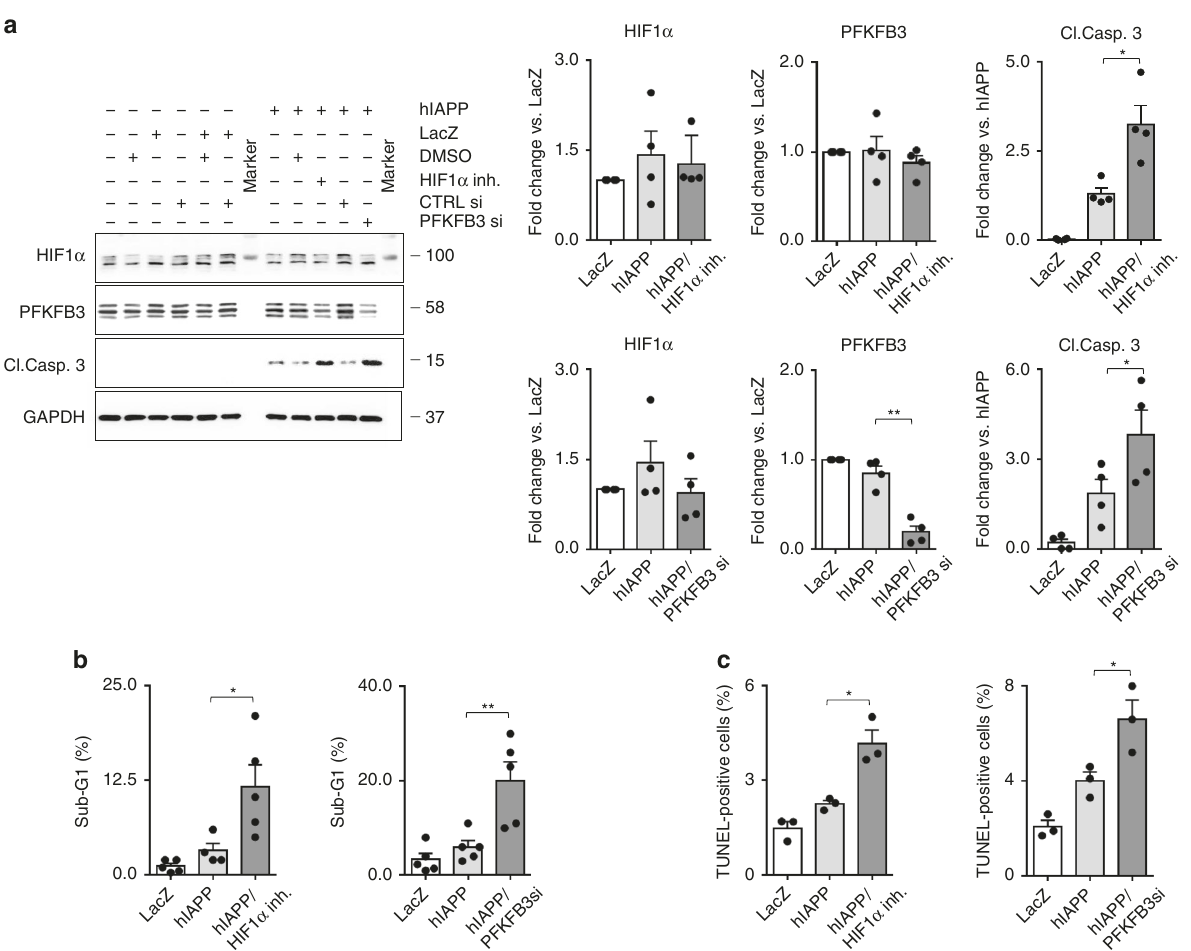
Fig. 9 HIF1 α and PFKFB3 are protective against hIAPP mediated β -cell death. a Representative immunoblotting (left) and quanti fi cation (right) of the whole cell extract (WCE) from asynchronous INS 832/13 cells treated with either HIF1 α inhibitor KC7F2 (10 μ M) or PFKFB3 siRNA (75 nM) for 56 h versus control. Cells were transduced with hIAPP adenovirus (75 MOI) or LacZ adenovirus as control (75 MOI) for last 32 h of culture. DMSO or CTRL siRNA, respectively were added to LacZ or hIAPP to equal DMSO or PFKFB3 siRNA used in experimental groups. GAPDH was used as a loading control. Data are presented as mean ± SEM, n = 4, * p < 0.05, ** p < 0.01. b Quanti fi cation of DNA content distribution after FACS analysis of INS 832/13 cells treated as described in ( a ). Data are the mean ± SEM, n = 4, * p < 0.05, ** p < 0.01. c The frequency of TUNEL positive INS 832/13 cells treated as described in ( a ). Data are the mean ± SEM, n = 4 in ( a ) and ( b ), and n = 3 independent experiments in ( c ). Statistical signi fi cance was analyzed by one-way ANOVA test with Tukey ’ s post-test (* p < 0.05, ** p < 0.01). See Supplementary Fig. 10 for additional supportive